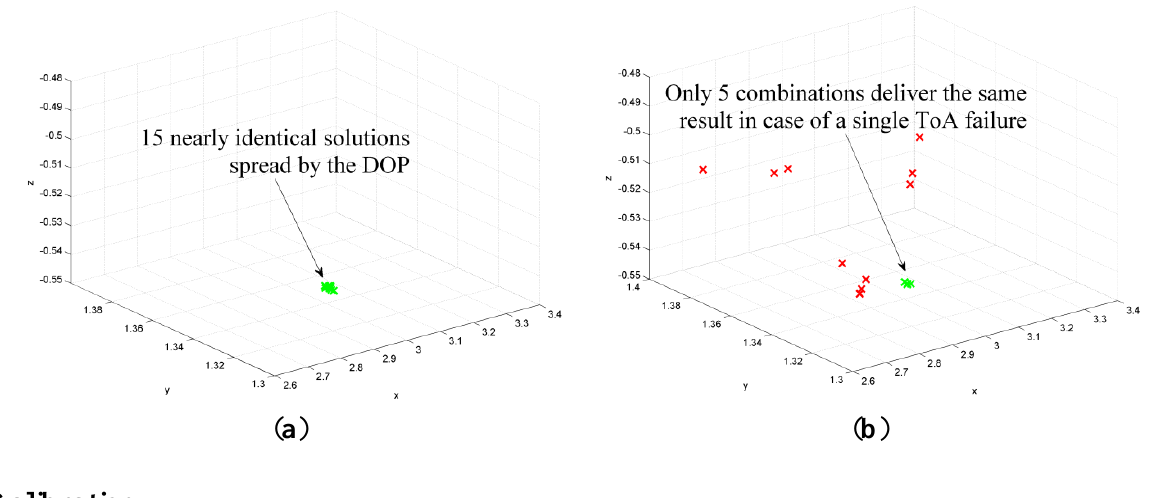
Figure 7. ( a ) Calculation of the receiver positions by all fifteen combinations in case of no error. All positions are close and spread by the DOP. ( b ) In case of a single outlier only five combinations are still valid and all others deliver different results. The assumed ToA error for this example was 1